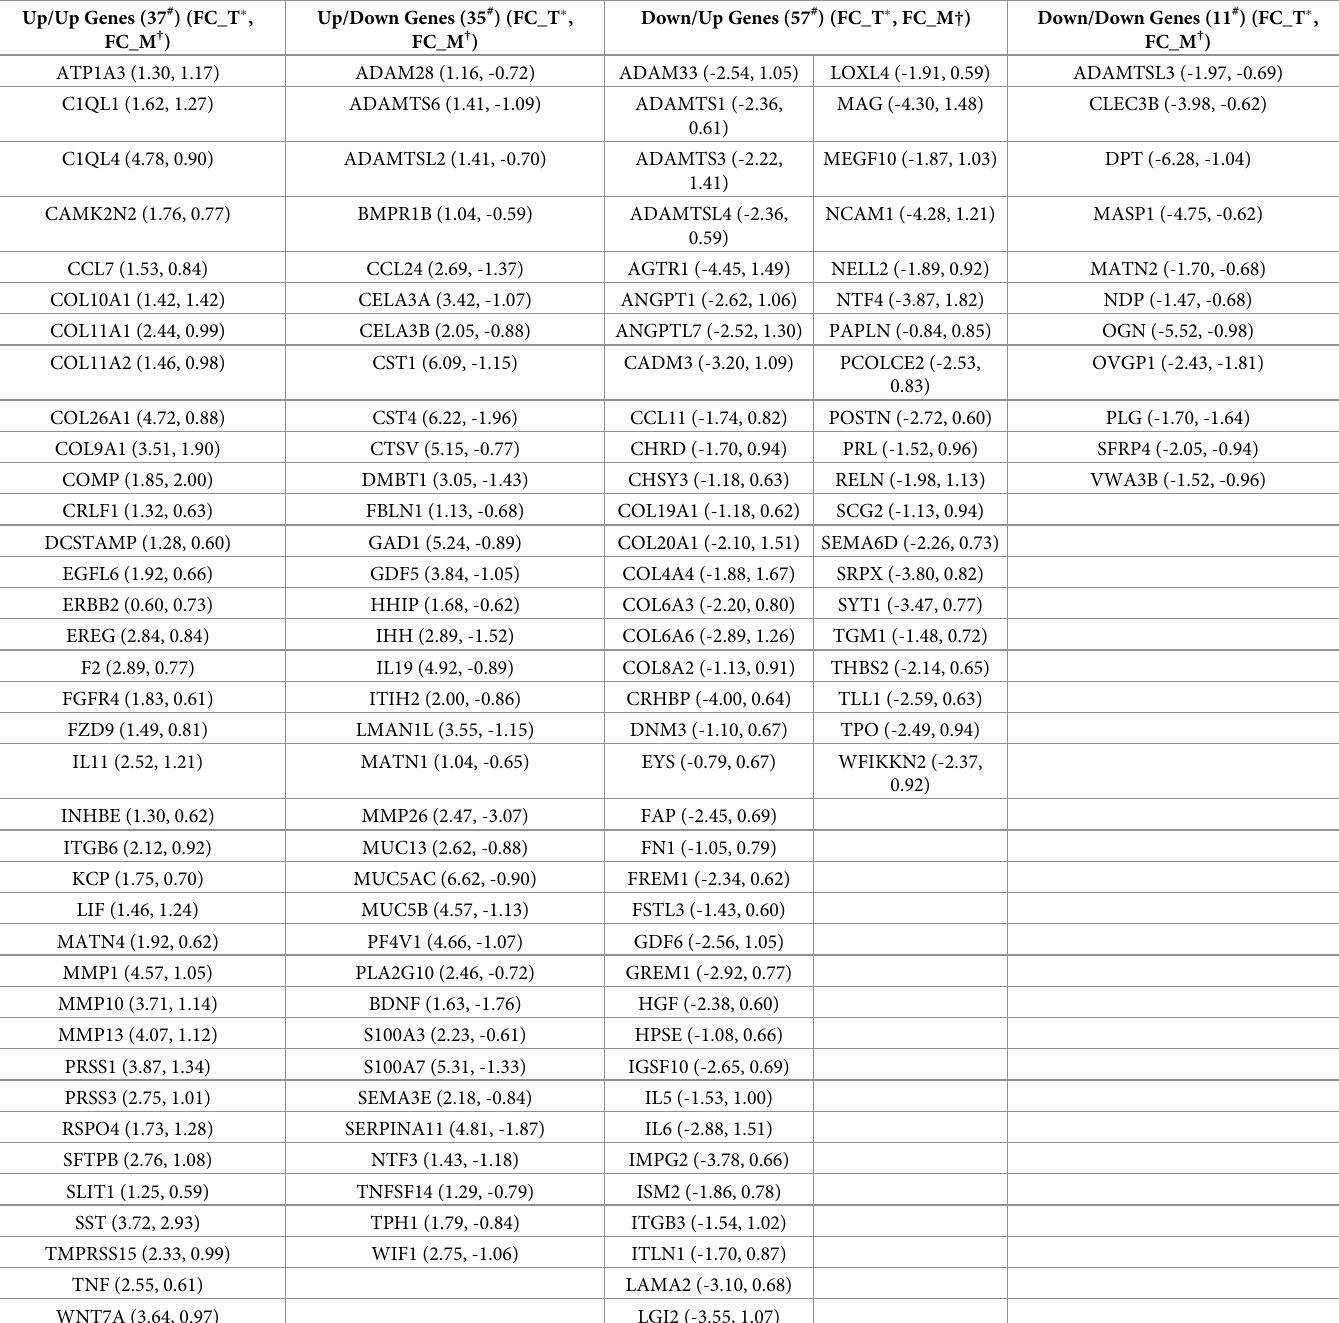
Table 1. The expression of 140 intersecting PAN-ECM DEGs in EC at tumorigenesis and metastasis stages. Up/Up Genes (37 # ) (FC_T �